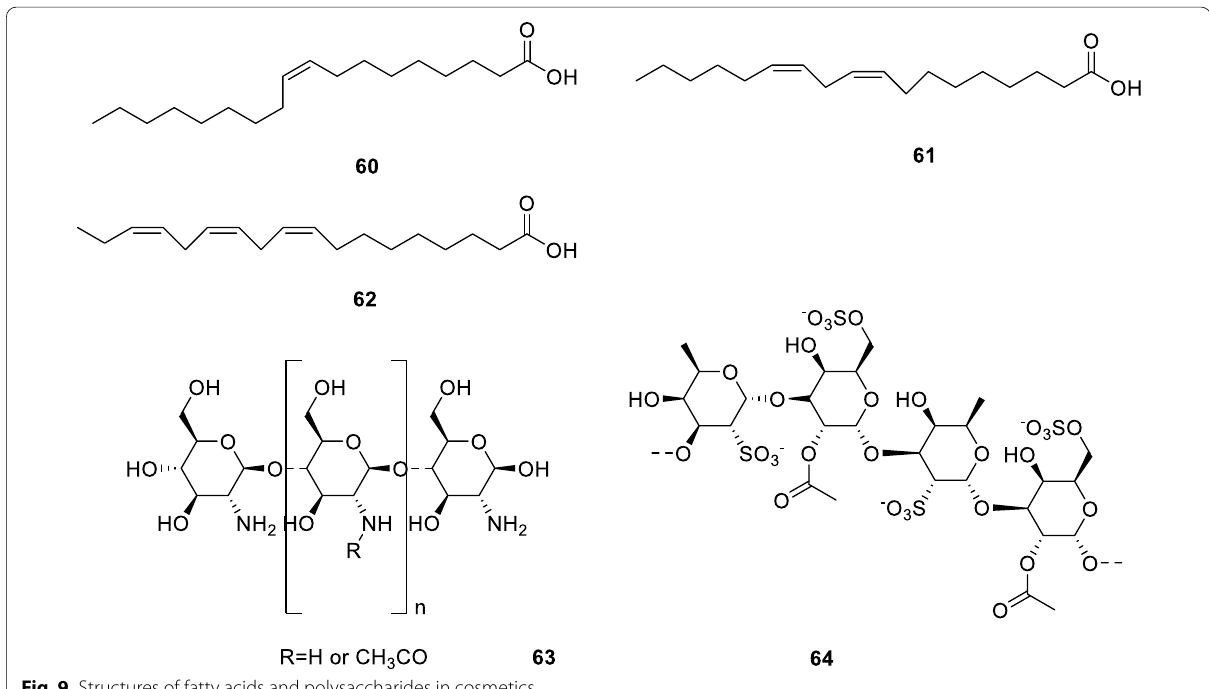
Fig. 9 Structures of fatty acids and polysaccharides in